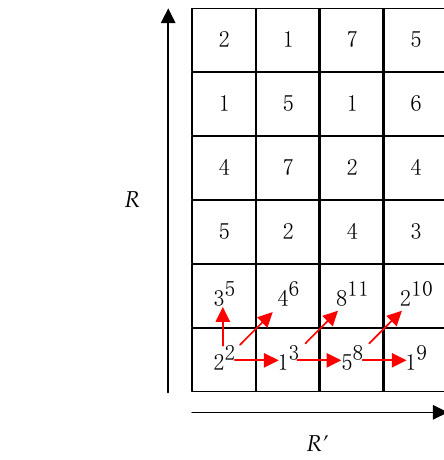
Figure 6. Similarity accumulation.